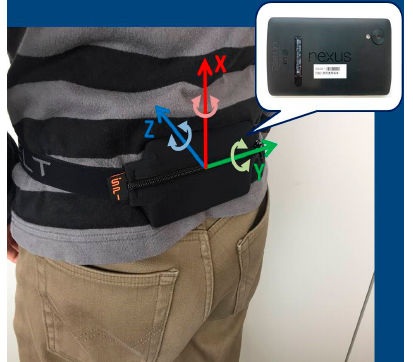
Figure 1. To measure sensor data required for pedestrian dead-reckoning (PDR), we asked the employees to carry the smartphone during the operation.